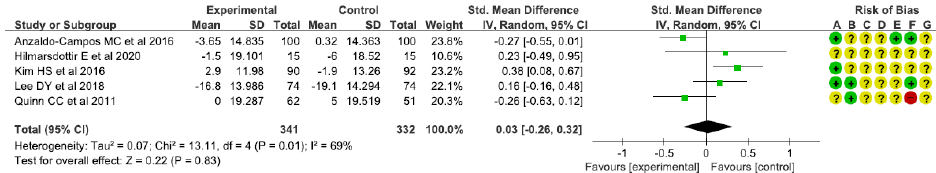
Figure 10. Forest plot for meta-analysis results on systolic blood pressure.